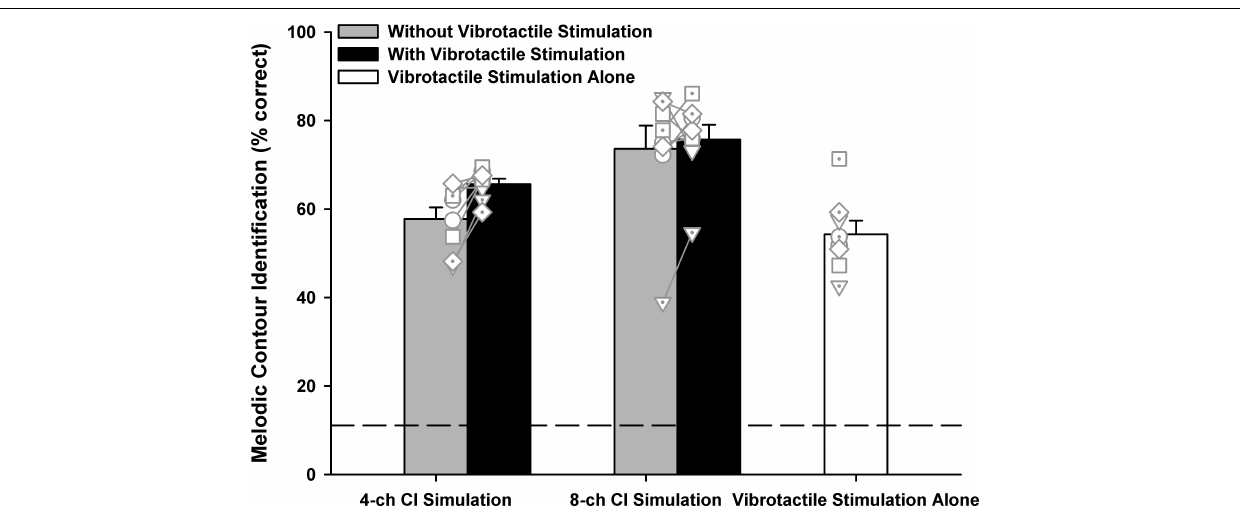
FIGURE 4 | Overall melodic contour identification scores with the 4- or 8-channel CI simulation (left two and middle two bars, respectively) with or without vibrotactile stimulation (black and gray bars, respectively) or with vibrotactile stimulation alone (white bar). Vertical bars represent the mean, while error bars represent the standard error across participants. Individual data points are shown by different symbols with or without dots. The horizontal dashed line indicates the chance performance of 11%